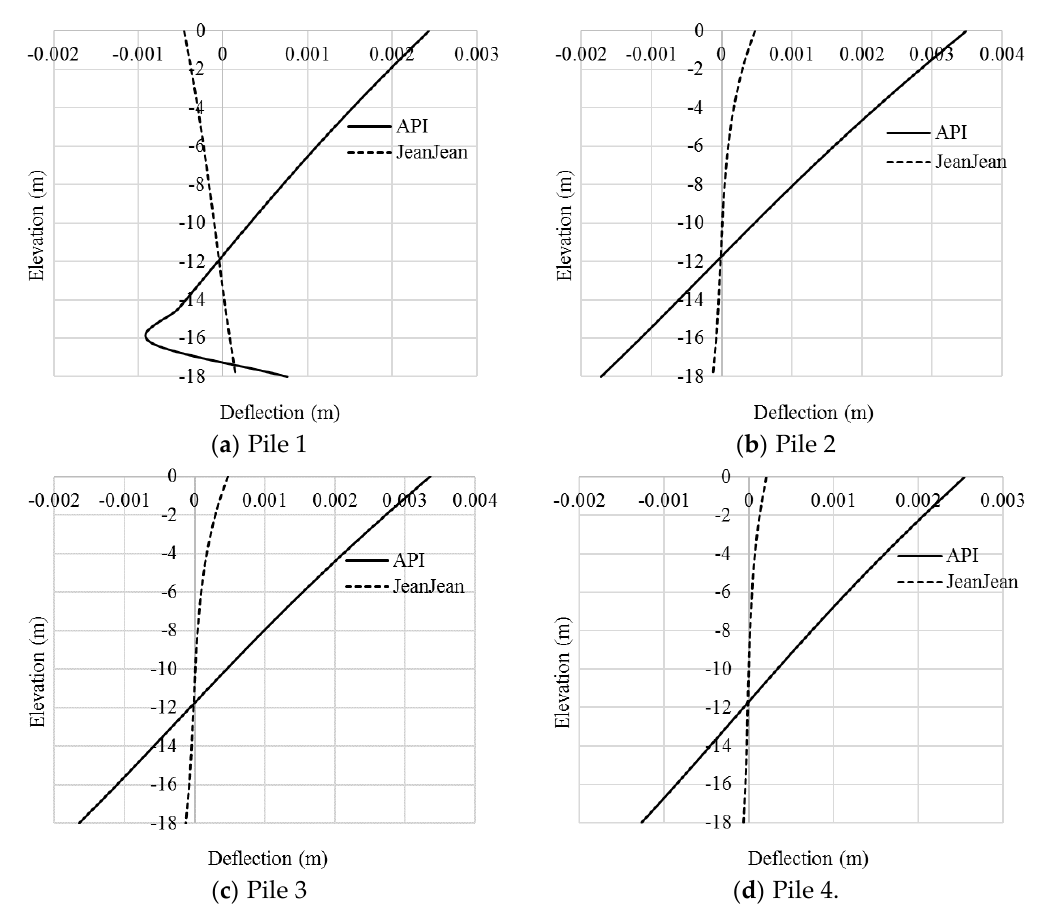
Figure 26. Pile deflection along the pile length.